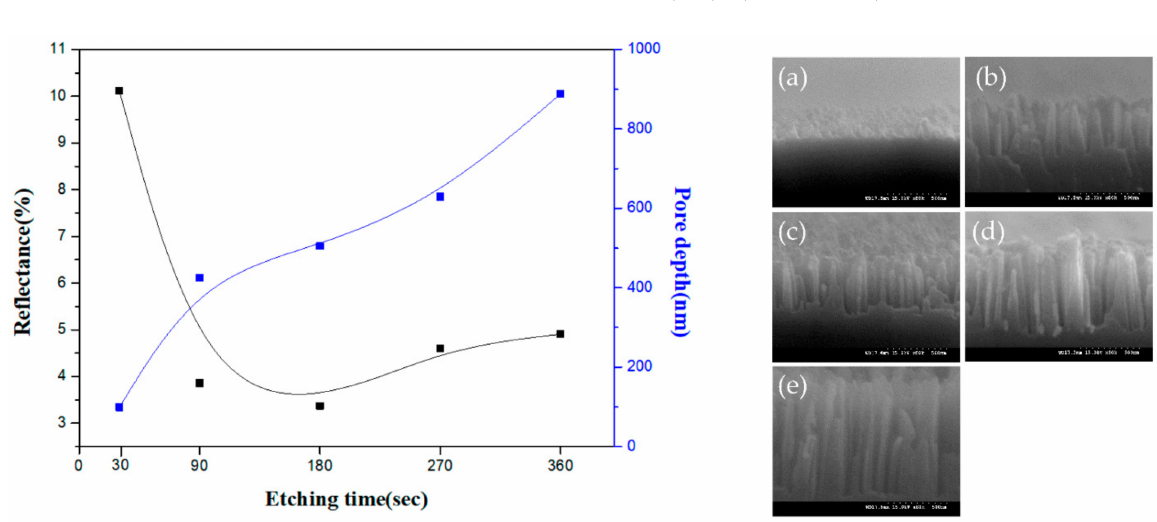
Figure 5. Reflectance and cross-section SEM images of wafer surfaces according to etching times for the MACE process: ( a ) 30 s, ( b ) 90 s, ( c ) 180 s, ( d ) 270 s, and ( e ) 360